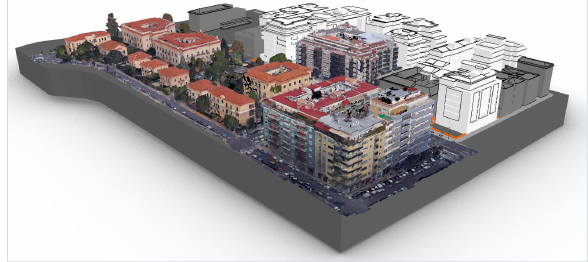
Figure 10 . NURBS modelling of the urban contest based on the point cloud acquisition